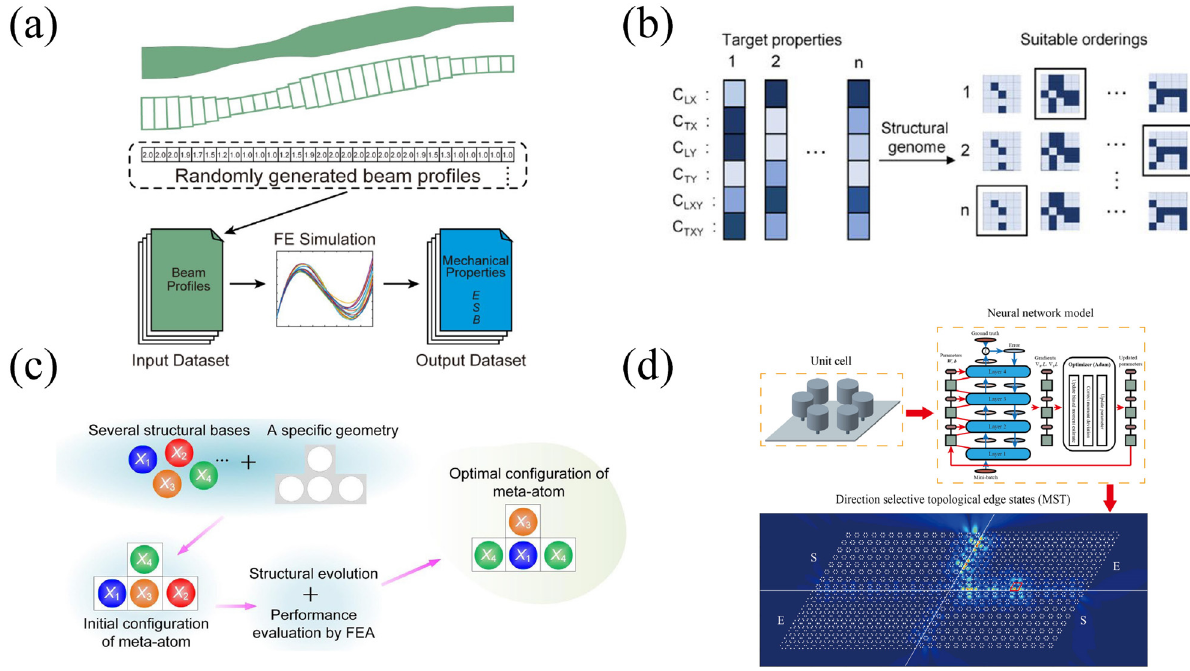
Figure 7: Applying neural networks for elastic metamaterials design. (a)Designofcurvedbeamswithvariablethickness[111].(b)Constructingstructuralgenomeofdigitalcodingmetamaterialsbyneuralnetwork to realize rapid structural screening for speci fi c wave velocity properties [112]. (c) Optimizing con fi guration of meta-atom to obtain modular metamaterialswithspeci fi cproperties[113].(d)Designofphononicthinplatewithspeci fi cbandgapwidthtorealizehighlyrobustelasticwave transmission